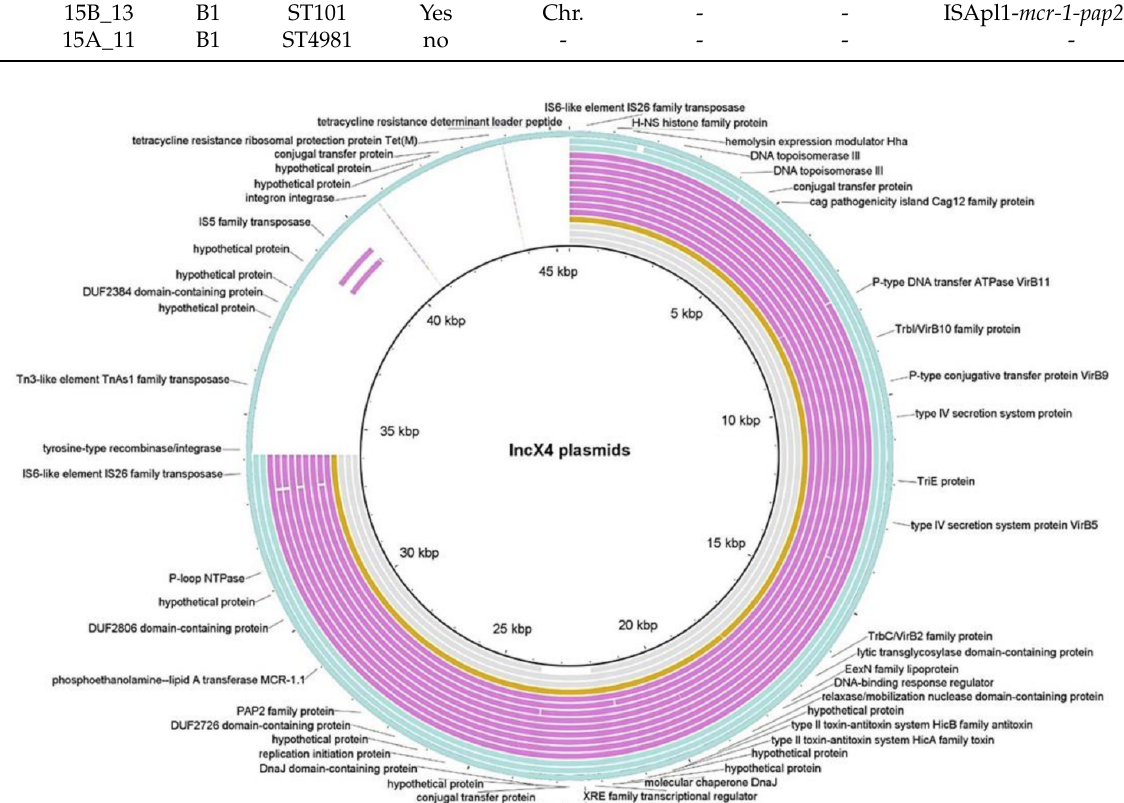
Figure 4. BLAST Ring Image Generator (BRIG) visualization of the 14 IncX4 plasmids from this study and three IncX4 plasmids from NCBI: pEC11b, pMCR1-NJ-IncX4, and pP744T-MCR1. Rings from outside to inside: P1_10, P2_2, P2_27 (blue); V7_18, V7_16, 15B_4, 15B_27, 15B_22, 15B_17, 15A_16, 14_4, 14_24, 14_20 (pink); farmer (orange); pP744T-MCR1, pMCR1-NJ-IncX4, pEC11b (grey). IncX4 plasmid from P1_10 is shown as the reference (longest sequence), with an extra- region of approximately 12,000 bp that is flanked by two IS26 elements and harbors the tetM gene conferring resistance